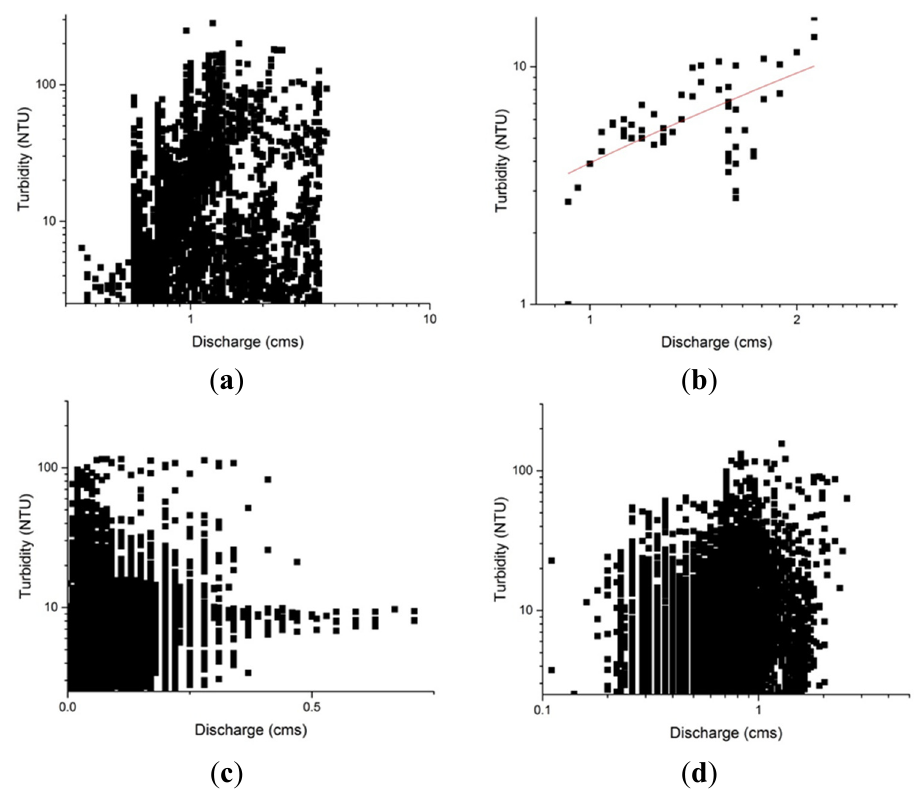
Figure 10. Variations in turbidity as a function of stream flow at the Allen Creek #1 ( a ); Cherry Cove ( c ); and Old Bald Creek #1 ( d ) monitoring stations; ( b ) variations in turbidity at the Allen Creek #1 site during the 15–16 March 2007 event